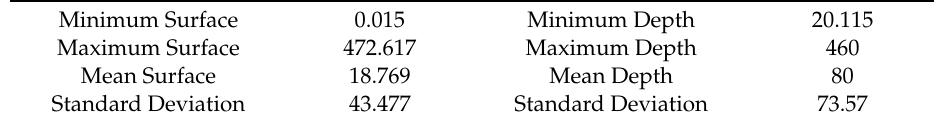
Table 1. Area (m 2 ) and depth (cm) of the permanent water cavities of Imlili